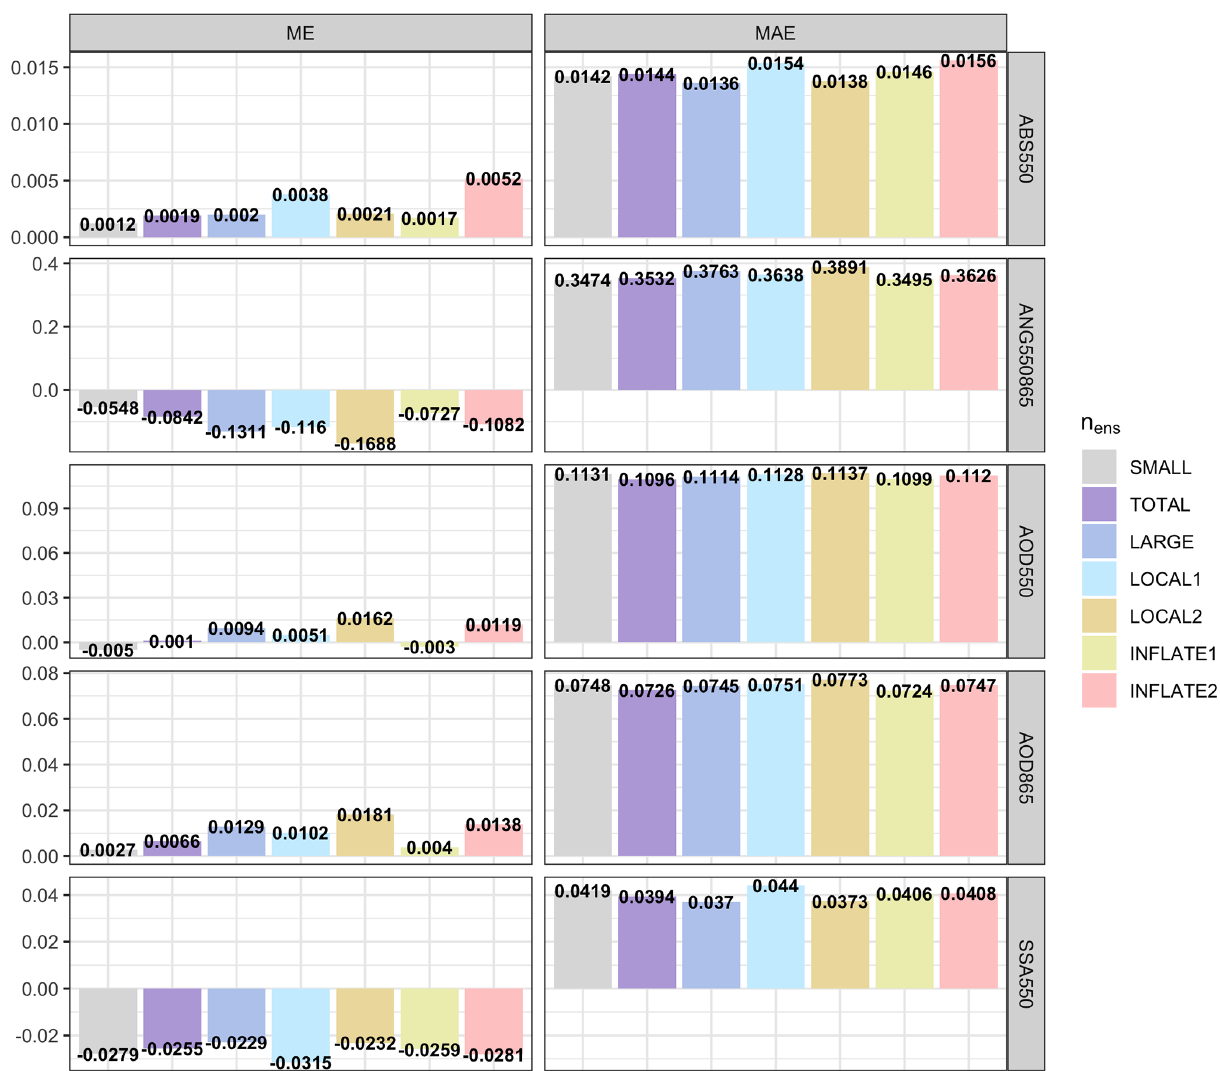
Figure 20. ME and MAE for all the spatiotemporal collocated points between AERONET (independent observations) and the experiments. AOD 550 , AOD 865 and AE 550–865 are calculated using the AERONET direct-Sun V3 L2 dataset, while AAOD 550 and SSA 550 are calculated using the AERONET aerosol inversion V3 L2